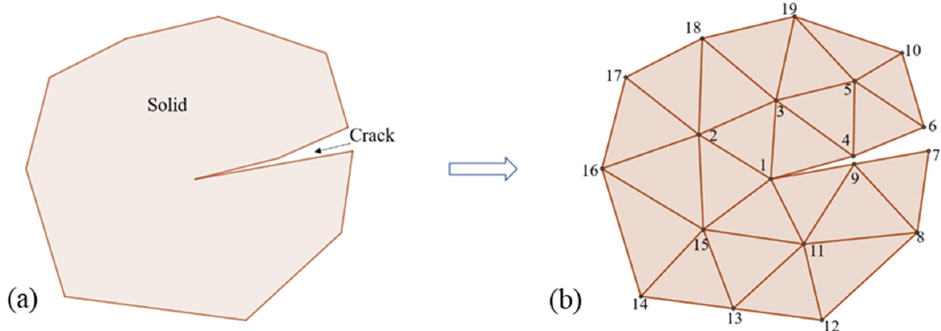
Figure 1. ( a ) continuous–discontinuous medium, ( b ) continuous–discontinuous medium calculation based on the initial mesh.